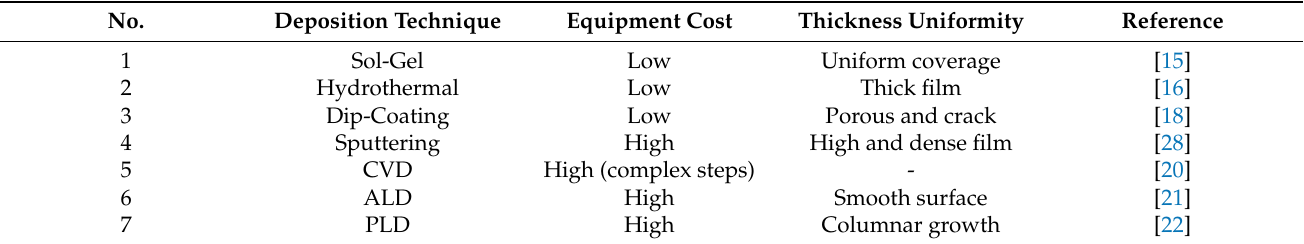
Table 1. Comparison of deposition techniques for ZnO